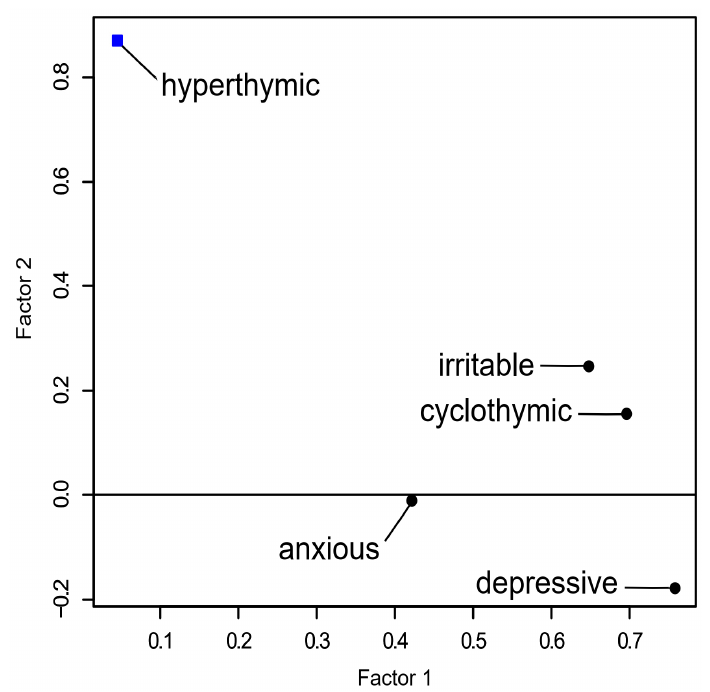
Figure 1. Exploratory factor analysis factor plot of five temperaments (varimax rotation).